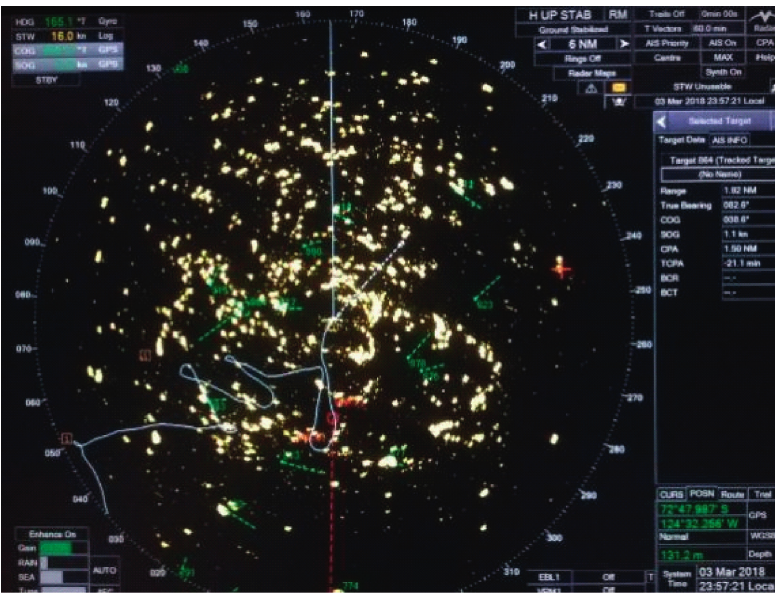
Figure 1: Typical radar echo image in polar ice-covered area.